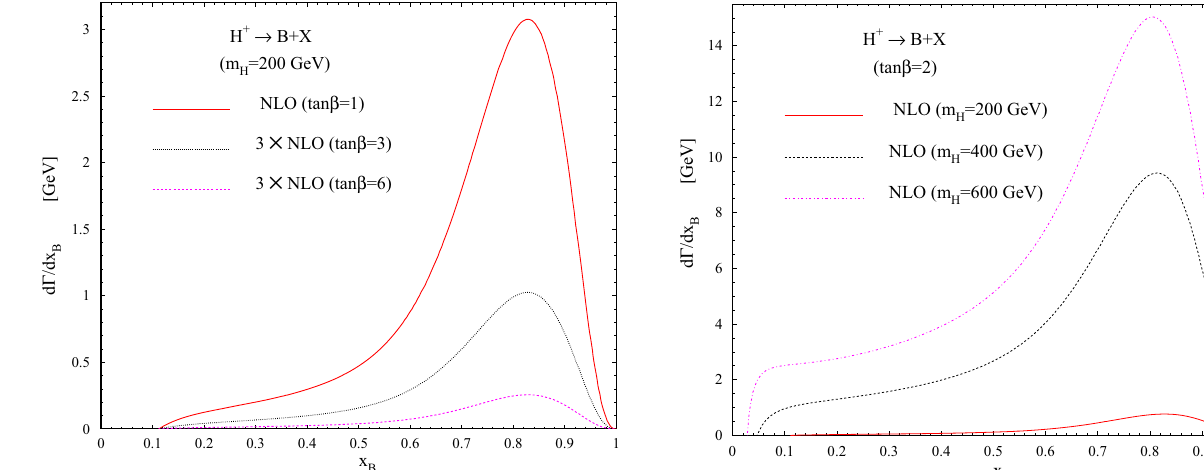
Fig. 3 The x B spectrum in charged Higgs decay for different values of charged Higgs mass: m H + = 200 GeV (solid line), m H + = 400 GeV (dashed line) and m H + = 600 GeV (dot-dashed